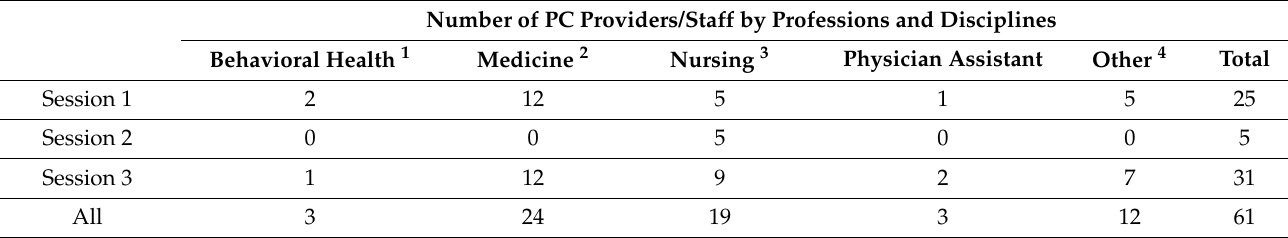
Table 2. Primary care staff education on social determinants of health by the PCL. Number of PC Providers/Staff by Professions and